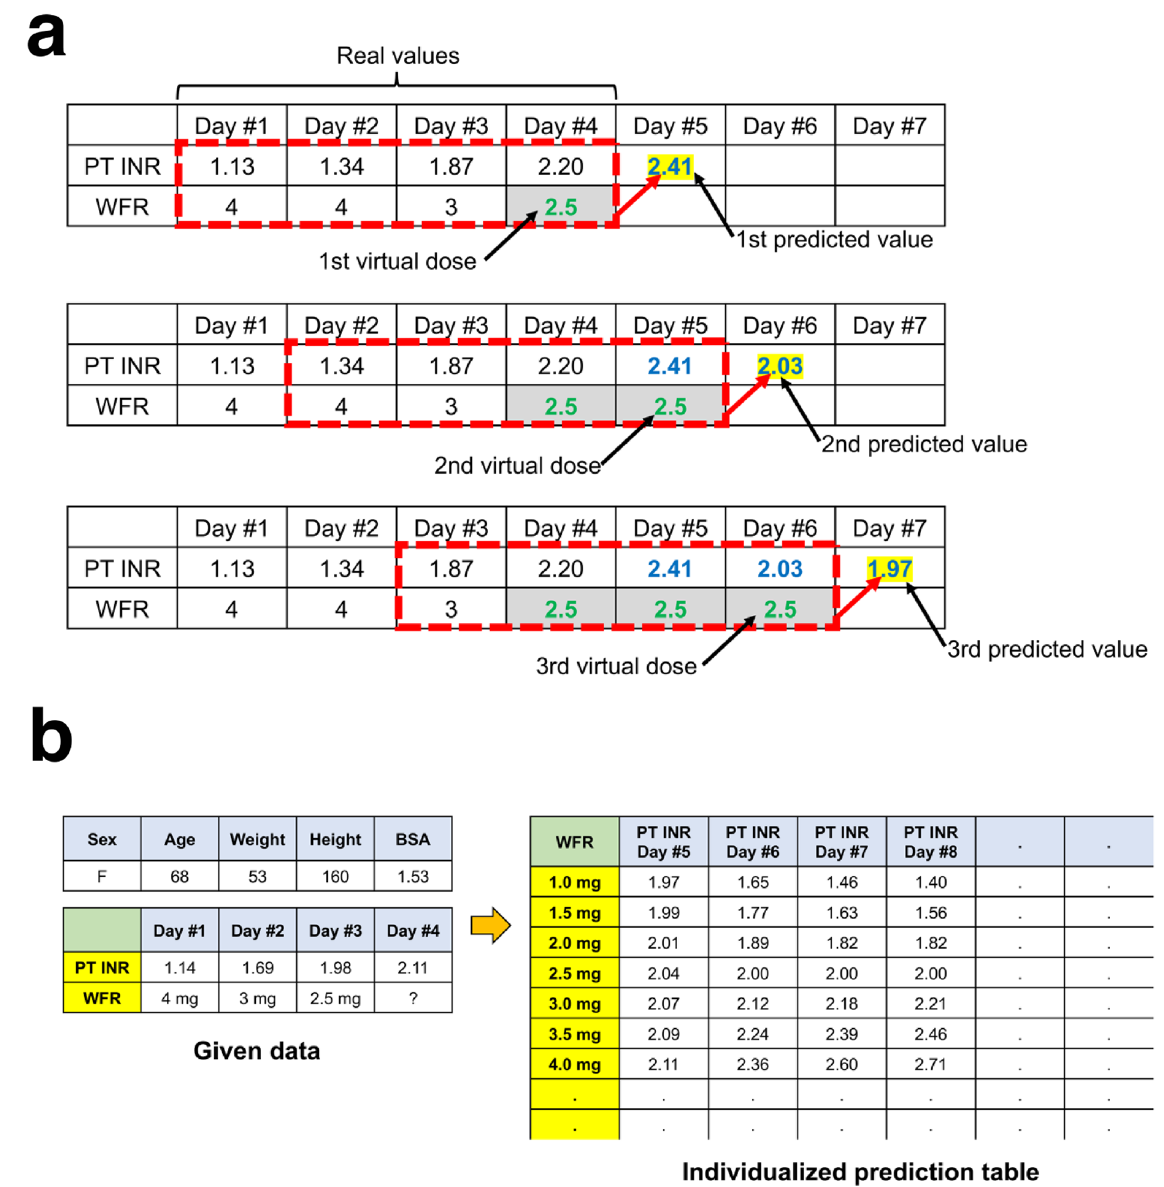
Figure 5. ( a ) A diagram showing how chain calculations are conducted. The chain calculation behind PT INR predictions were based on the assumption that fixed doses of warfarin were administered. The PT INRs on days 1–4 and the warfarin doses administered on days 1–3 were real values. An assumed warfarin dose for day 4 was added. With data from days 1–4, the 5th-day PT INR can be predicted. Another virtual warfarin dose for day 5 was added. With data from days 2–5, the 6th-day PT INR can be predicted. ( b ) An example of an individualized warfarin dose-PT INR table. The chain calculation can be conducted for any fixed dose of warfarin. Therefore, the algorithm can generate individualized warfarin dose-PT INR prediction tables. Physicians can refer to them when determining the warfarin dose. BSA body surface area, PT INR prothrombin time international normalized ratio, WFR